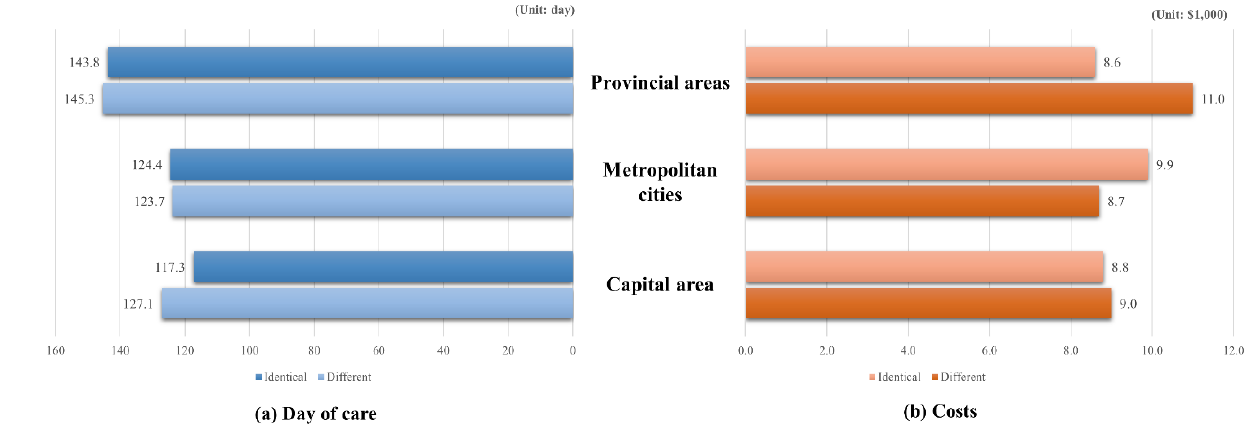
Figure 2. The average number of days of care and costs by residing area. Table 1. General characteristics of the study population.